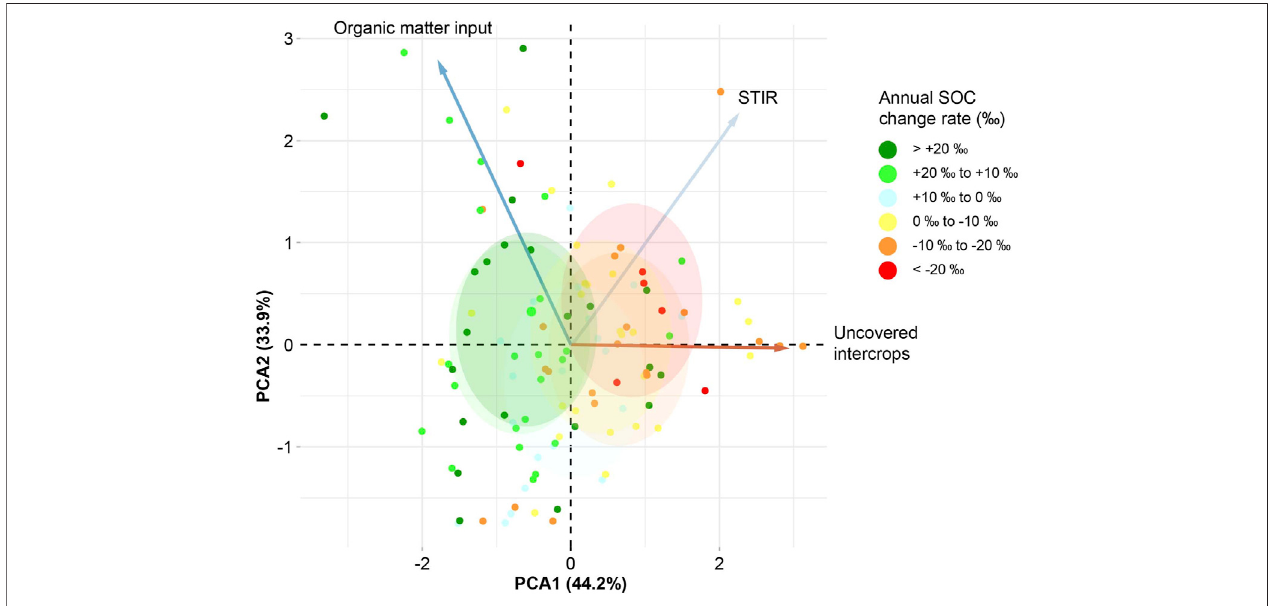
FIGURE 5 | PCA biplot of the 120 studied fi elds together with the agricultural practices retained in the linear model projected on plane of the fi rst two principal components (variance in %). Each fi eld is colored according to its annual SOC change rate ( ‰ ). Euclidean concentration ellipses follow the same color scale.